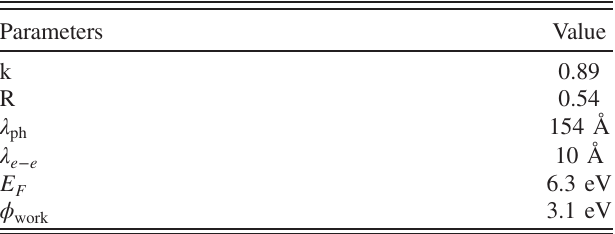
TABLE II. Yttrium optical and physical parameters at λ ¼ 392 nm used to compute the QE [25].